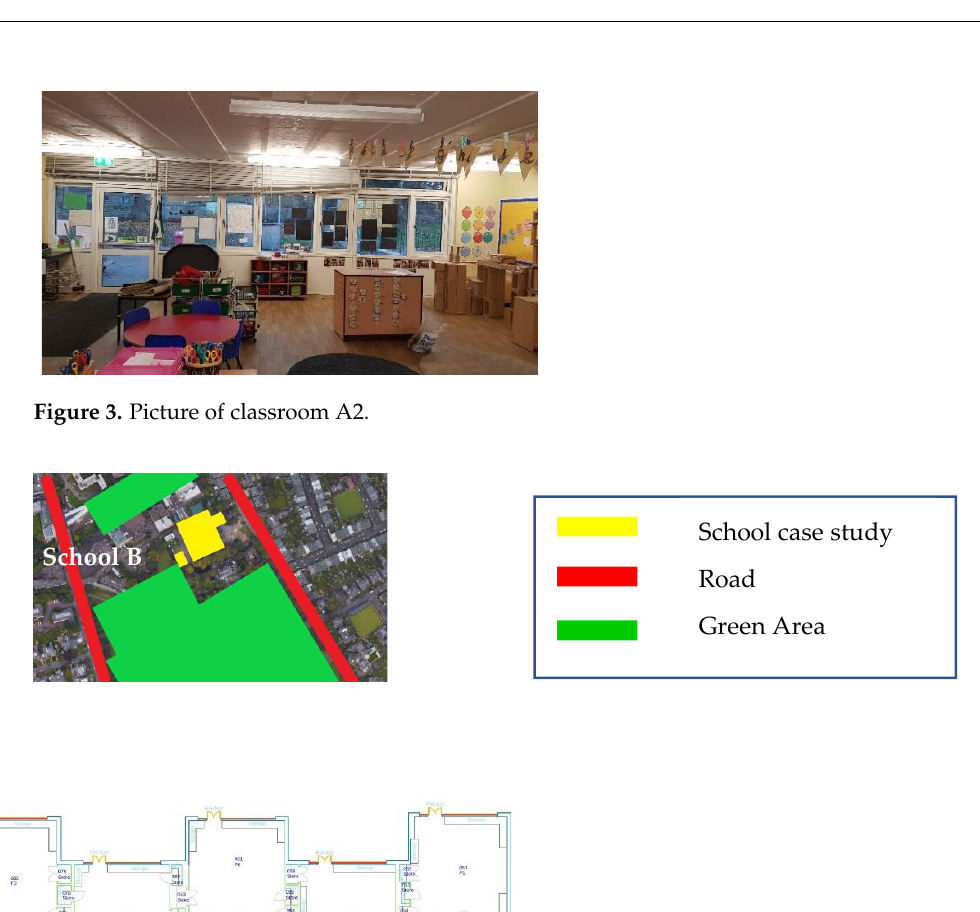
4 Figure 1. School A.